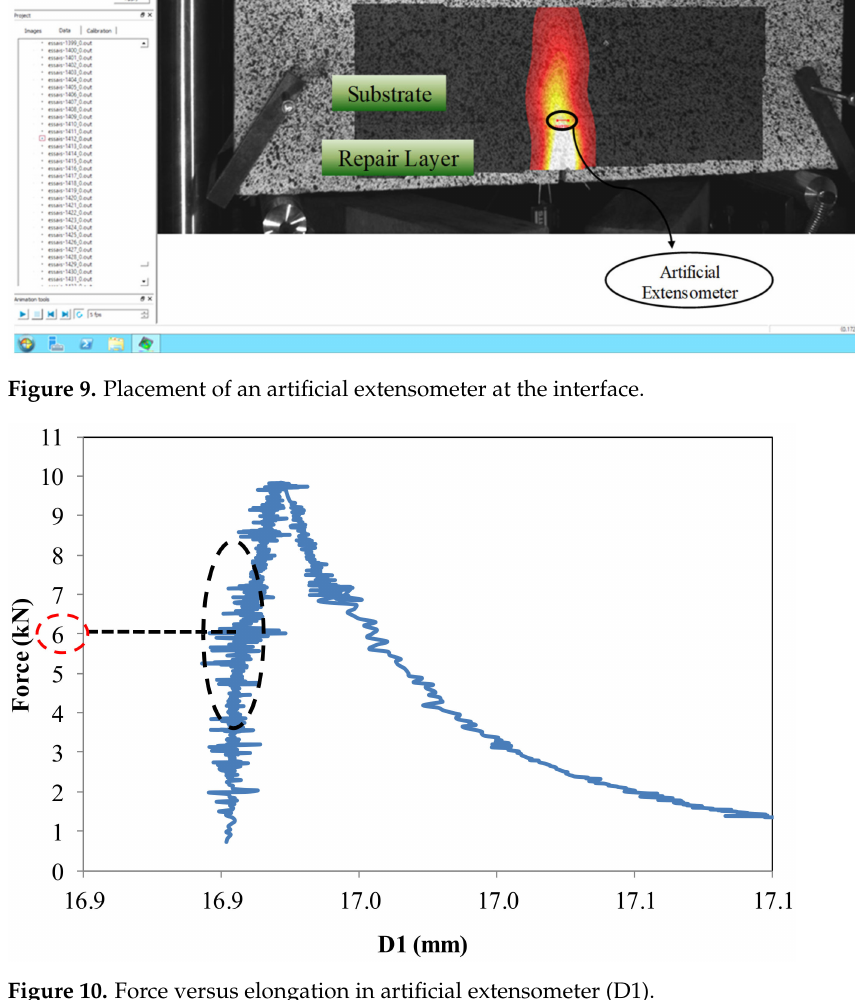
Figure 10. Force versus elongation in artificial extensometer